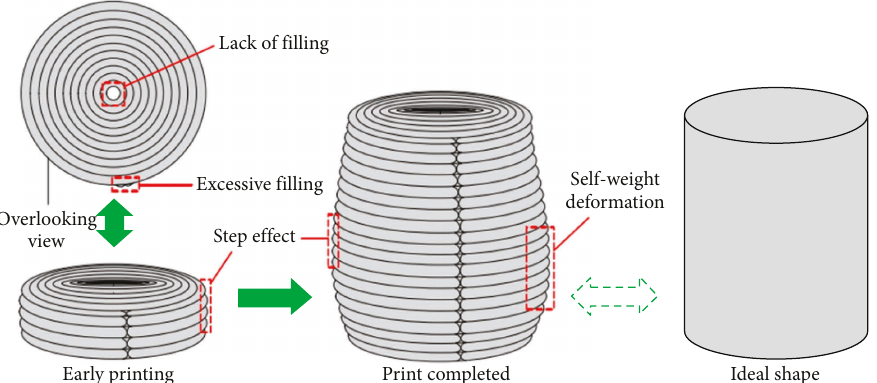
Figure 25: Step effect and other molding defects [1].